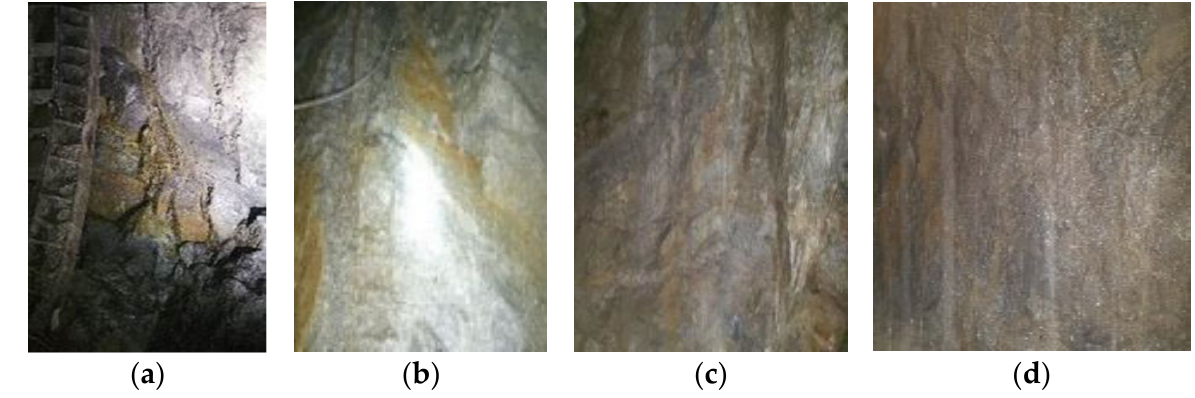
Figure 4. Pictures of weakly and strongly weathered granite. ( a ) Weakly; ( b ) Weakly; ( c ) Strongly; ( d ) Strongly.